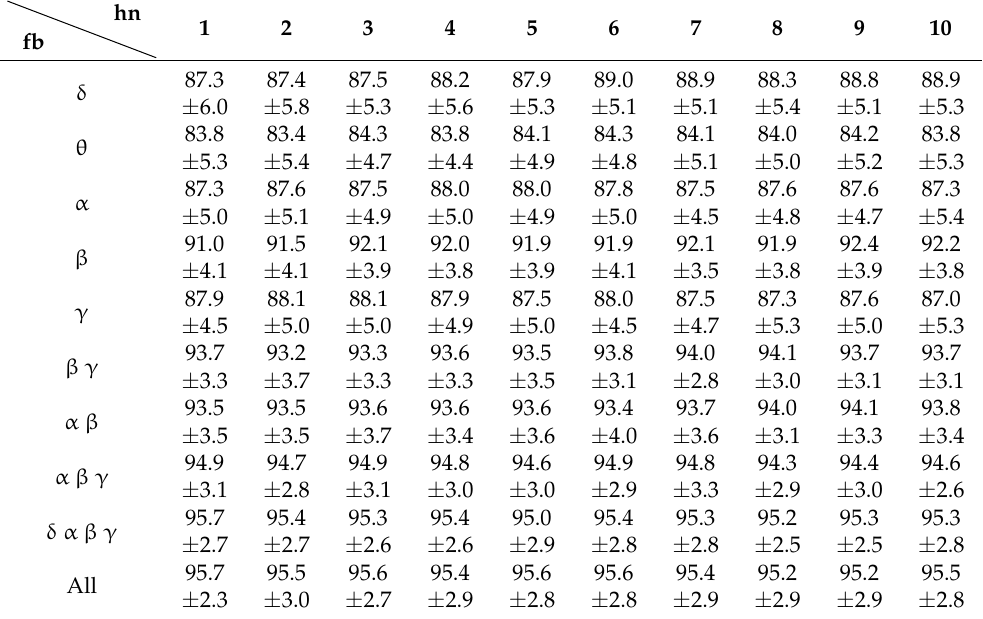
Table 1. Mean and standard deviation of accuracy for selected EEG frequency bands (fb) and a different number of hidden neurons (hn). Results for the first scenario in which feature set vectors for the training and testing datasets were derived from each recording